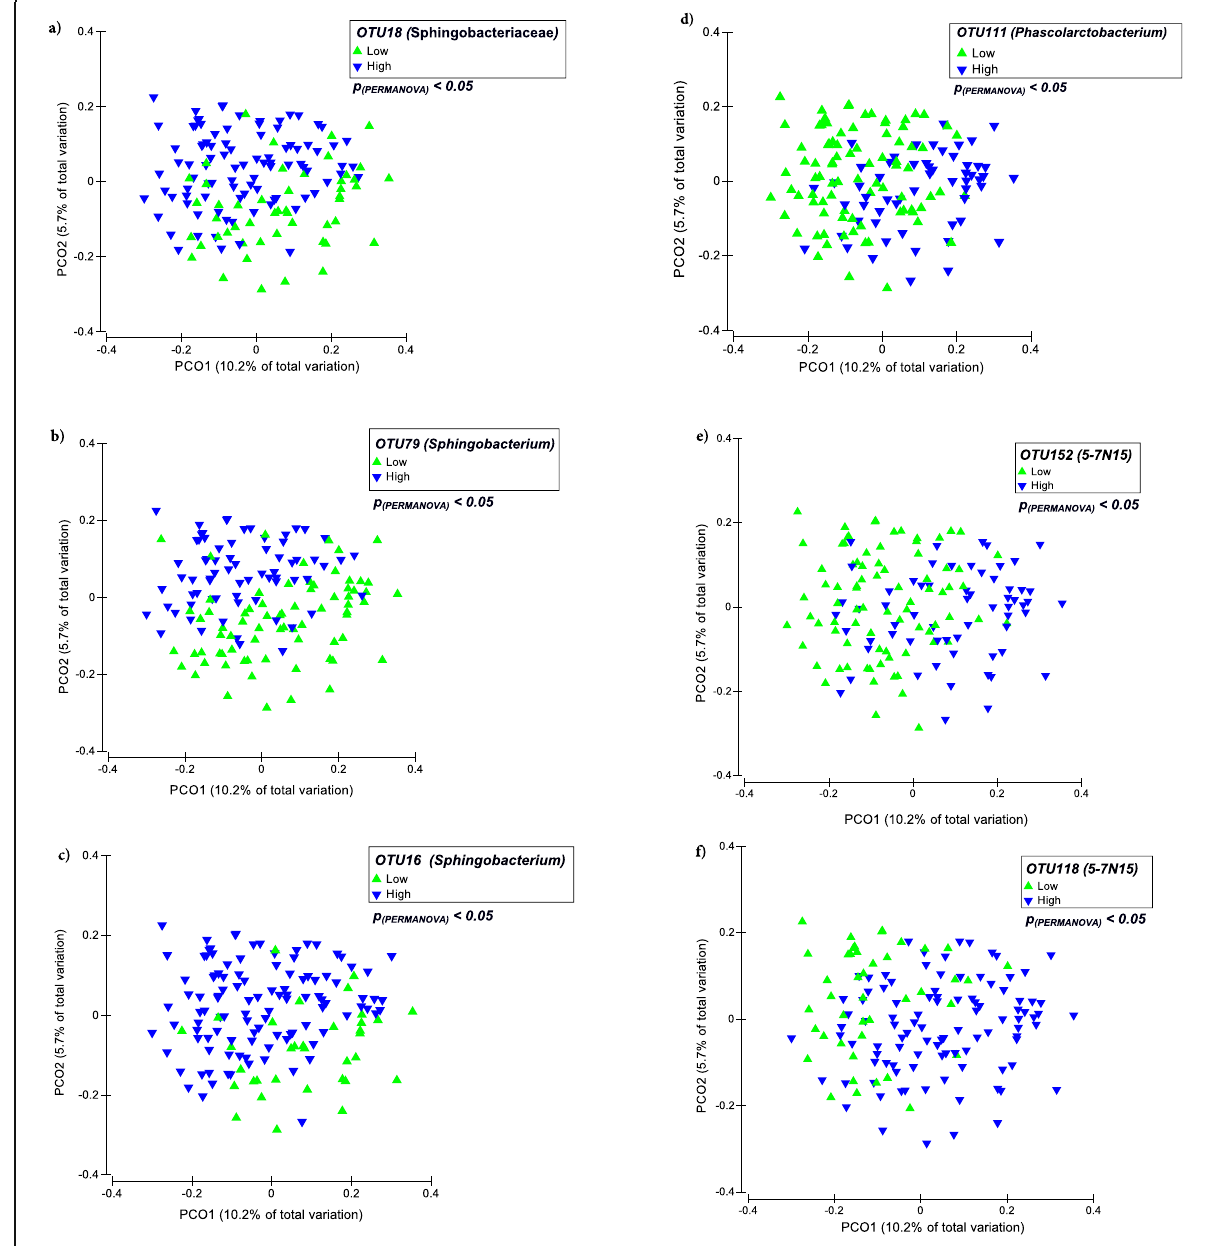
Fig. 5 Clustering of milk samples based on the abundance of hub OTUs. Principal coordinate analysis (PCoA) was used for visualization of Bray- Curtis dissimilarities of the milk microbial communities. The OTU table was normalized using cumulative sum scaling (CSS) transformation. PERMANOVA was used to test for distinction of clustering patterns based on the counts of selected hub OTUs ( a-f ). Samples were categorized into two groups that either contained high ( ≥ 10 OTUs/4000 sequencing reads) or low (< 10 OTUs/4000 sequencing reads) number of the selected hub OTUs. The effect of cow was included as random factor in all comparison. For all tests, p -values < 0.05 were considered